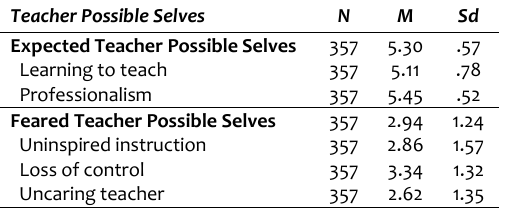
Table 2. Descriptive statistics for preservice English teachers' possible selves Teacher Possible Selves N M Sd Expected Teacher Possible